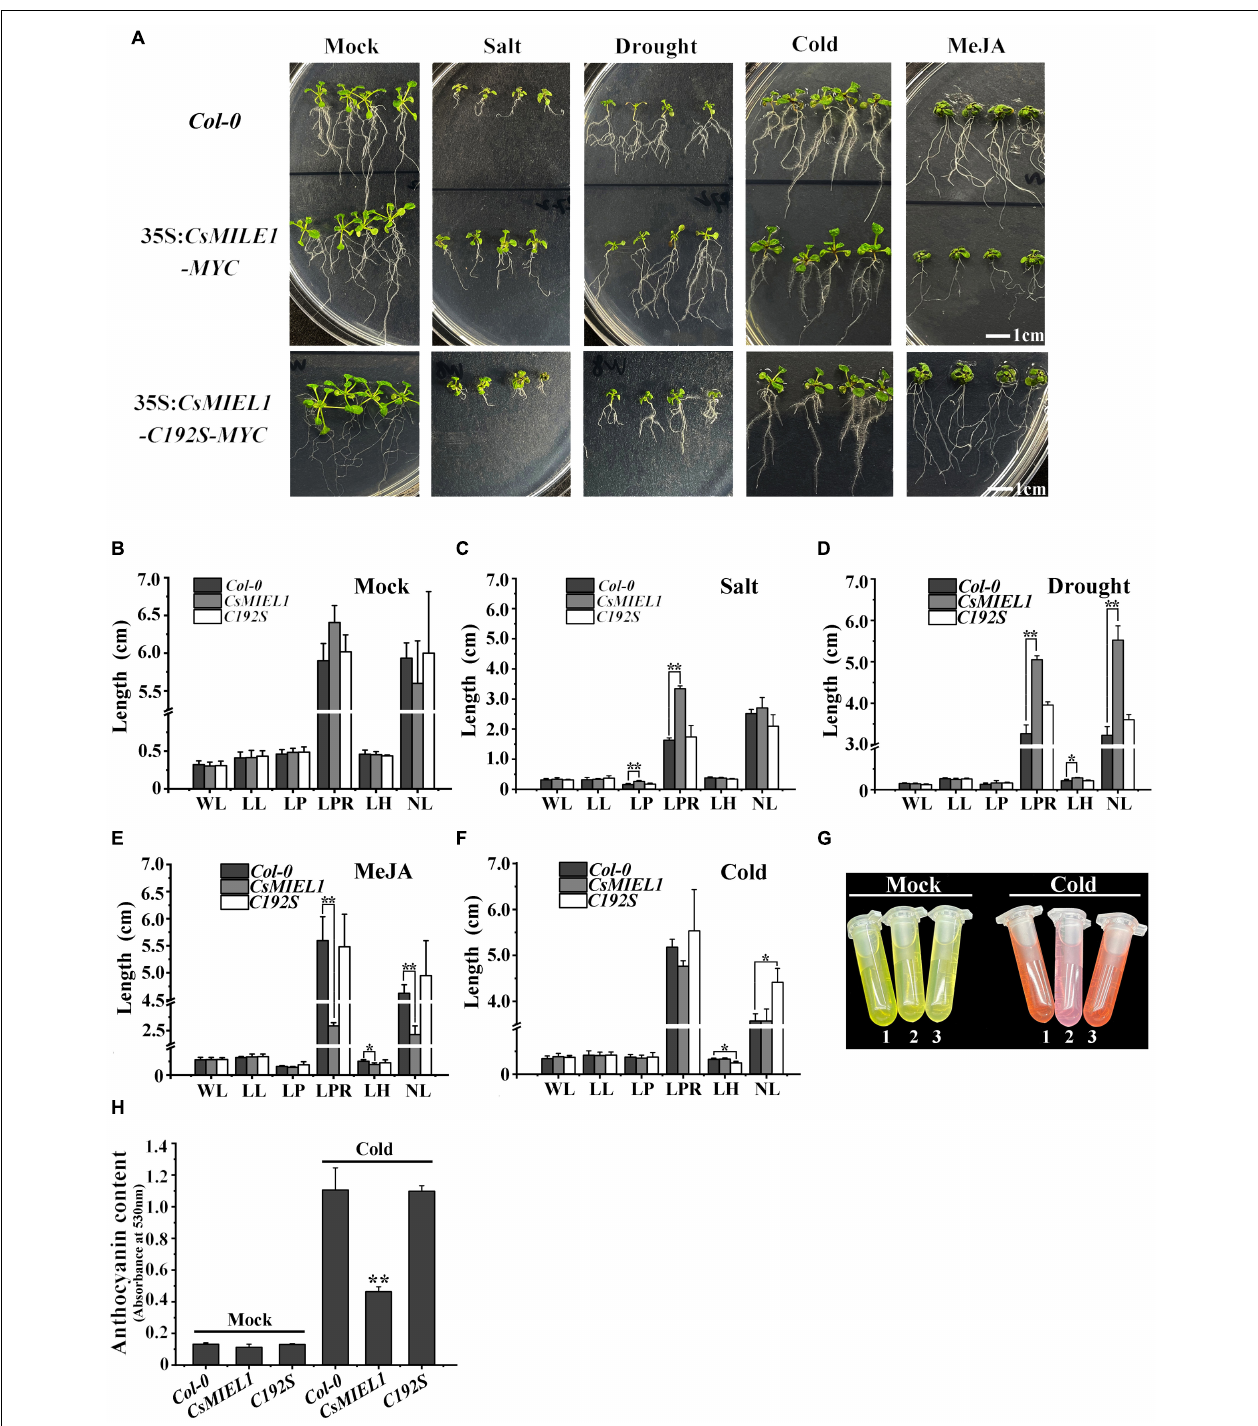
FIGURE 6 | Resistance experiment of transgenic Arabidopsis plants to four stresses. (A) Four stress treatments for wild-type ( Col-0 ), CsMIEL1 , and CsMIEL1-C192S overexpressing Arabidopsis thaliana seedlings. (B–F) Data on each index of the three types of seedlings under the four stress treatments. Mock, Seedlings without stress treatment; WL, Width of leaf; LL, Length of leaf; LP, Length of petiole; LPR, Length of primary root; LH, Length of hypocotyl; NL, Number of lateral roots. (G,H) Anthocyanin concentration of three Arabidopsis genotype under cold stress and normal conditions. In all biological replicates, at least 50 plants were used for each treatment, and the error bars represent the standard deviation of replicates. The asterisks indicate the significance level (* P < 0.05, ** P < 0.01) based on the LSD’s honestly significant difference test.